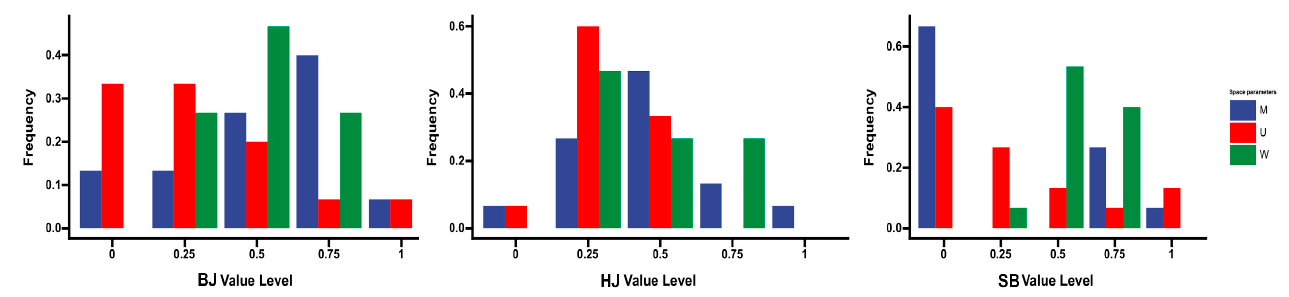
Figure 10. Spatial structure of ASV. The W stands for angular scale, M stands for mixing degree, and U stands for the size ratio.